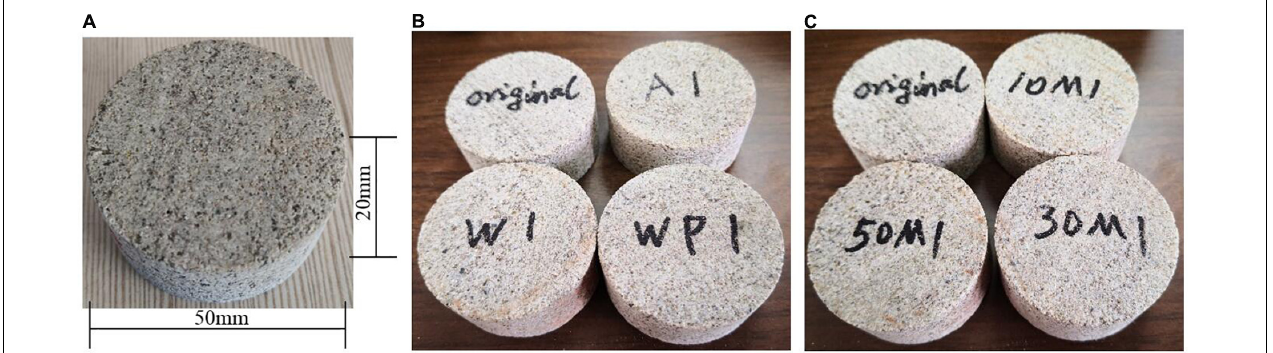
FIGURE 1 | Geometry of gritstone specimen and photos: (A) geometry; (B) the Ht group; (C) the Cd